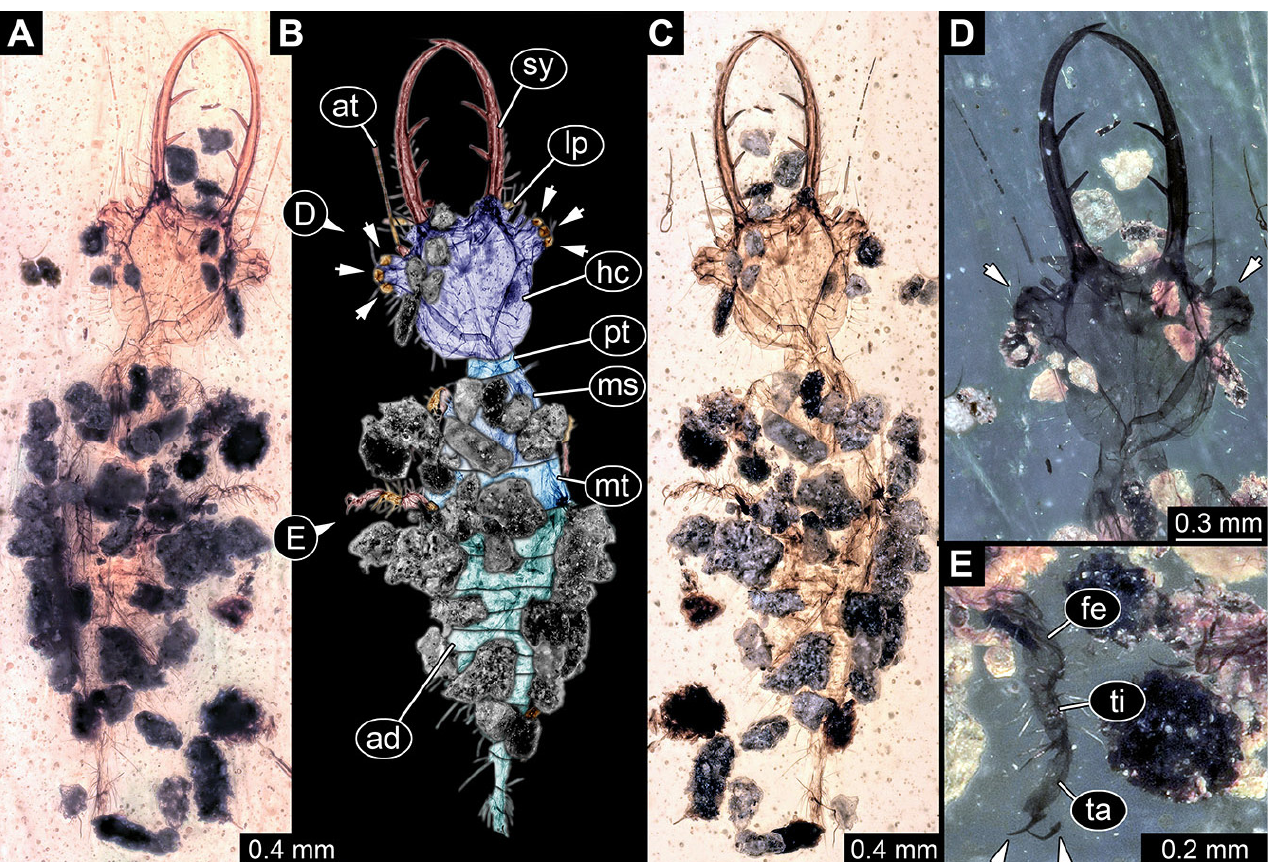
Figure 12. Fossil owllion larva, specimen 3224 (BUB 3724), Cretaceous Kachin amber, Myanmar. ( A ) Overview, ventral. ( B ) Color-marked version of ( C ); arrows point to stemmata. ( C ) Overview, dorsal. ( D ) Close-up on head capsule with fields of stemmata (arrows). ( E ) Close-up on locomotory appendage with claws (arrows). Abbreviations: ad = abdomen; at = antenna; fe = femur; hc = head capsule; lp = labial palp; ms = mesothorax; mt = metathorax; pt = prothorax; sy = stylet; ta = tarsus; ti = tibia.